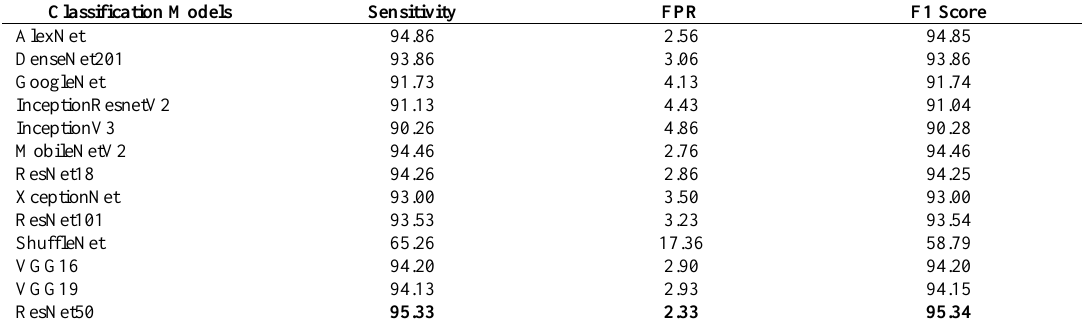
Table 5. Performance measures (%) in terms of sensitivity, FPR and F1 score of different classification models based on SVM using deep features of various CNN models Classification Models